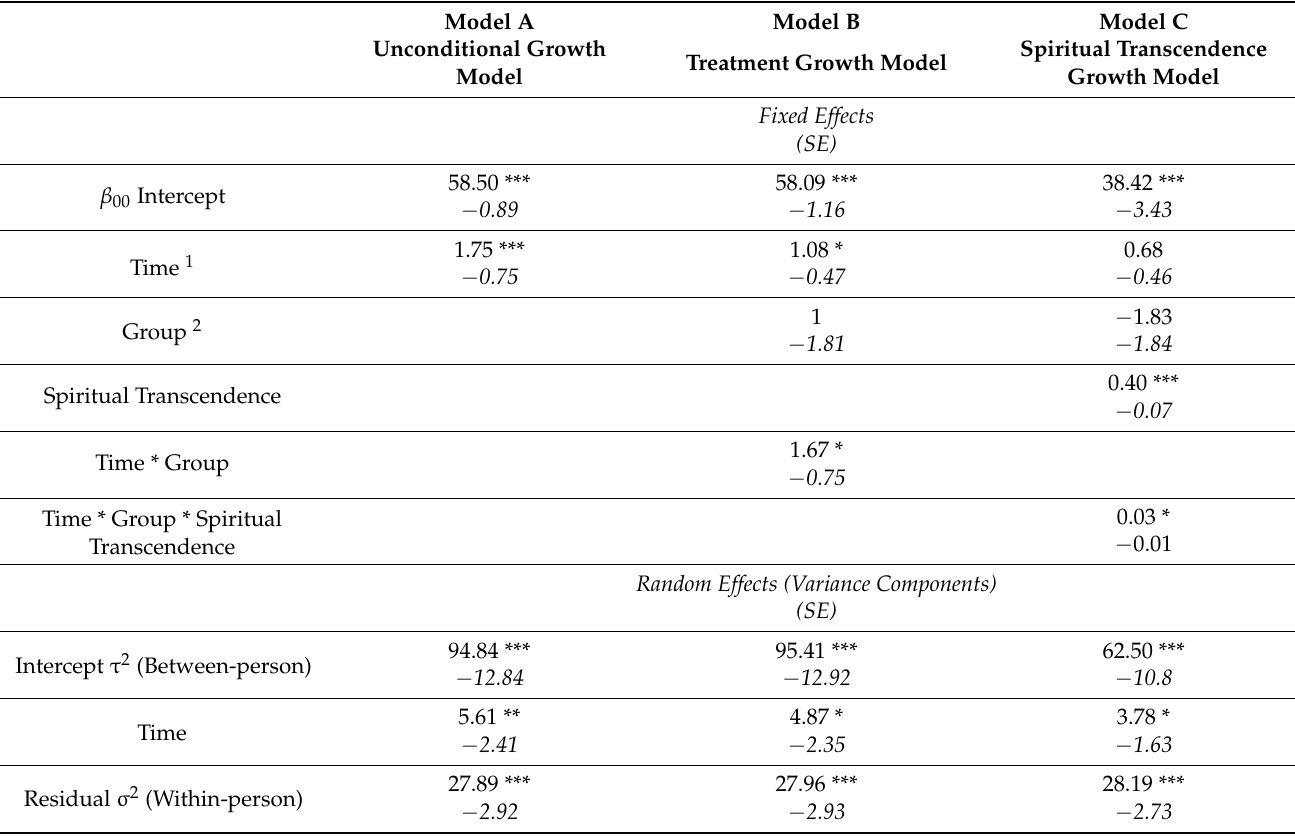
Table 2. Parameter estimates for growth curve models A–C predicting the trajectory of